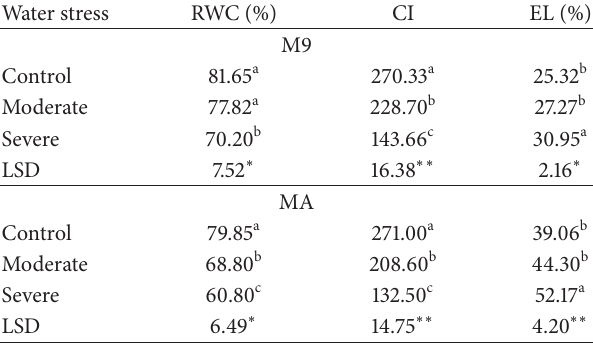
Table 2: Relative water content (RWC), chlorophyll index (CI), and electrolyte leakage (EL) of M9 and MA rootstocks grown under water stress